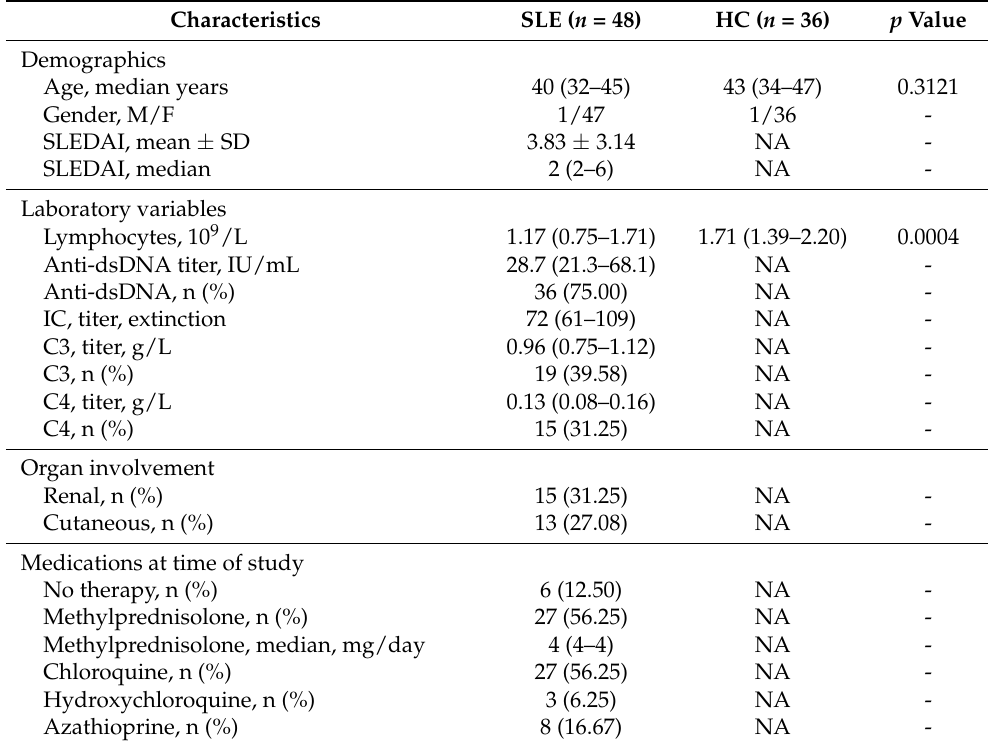
Table 1. Demographic characteristic of patients with SLE and healthy